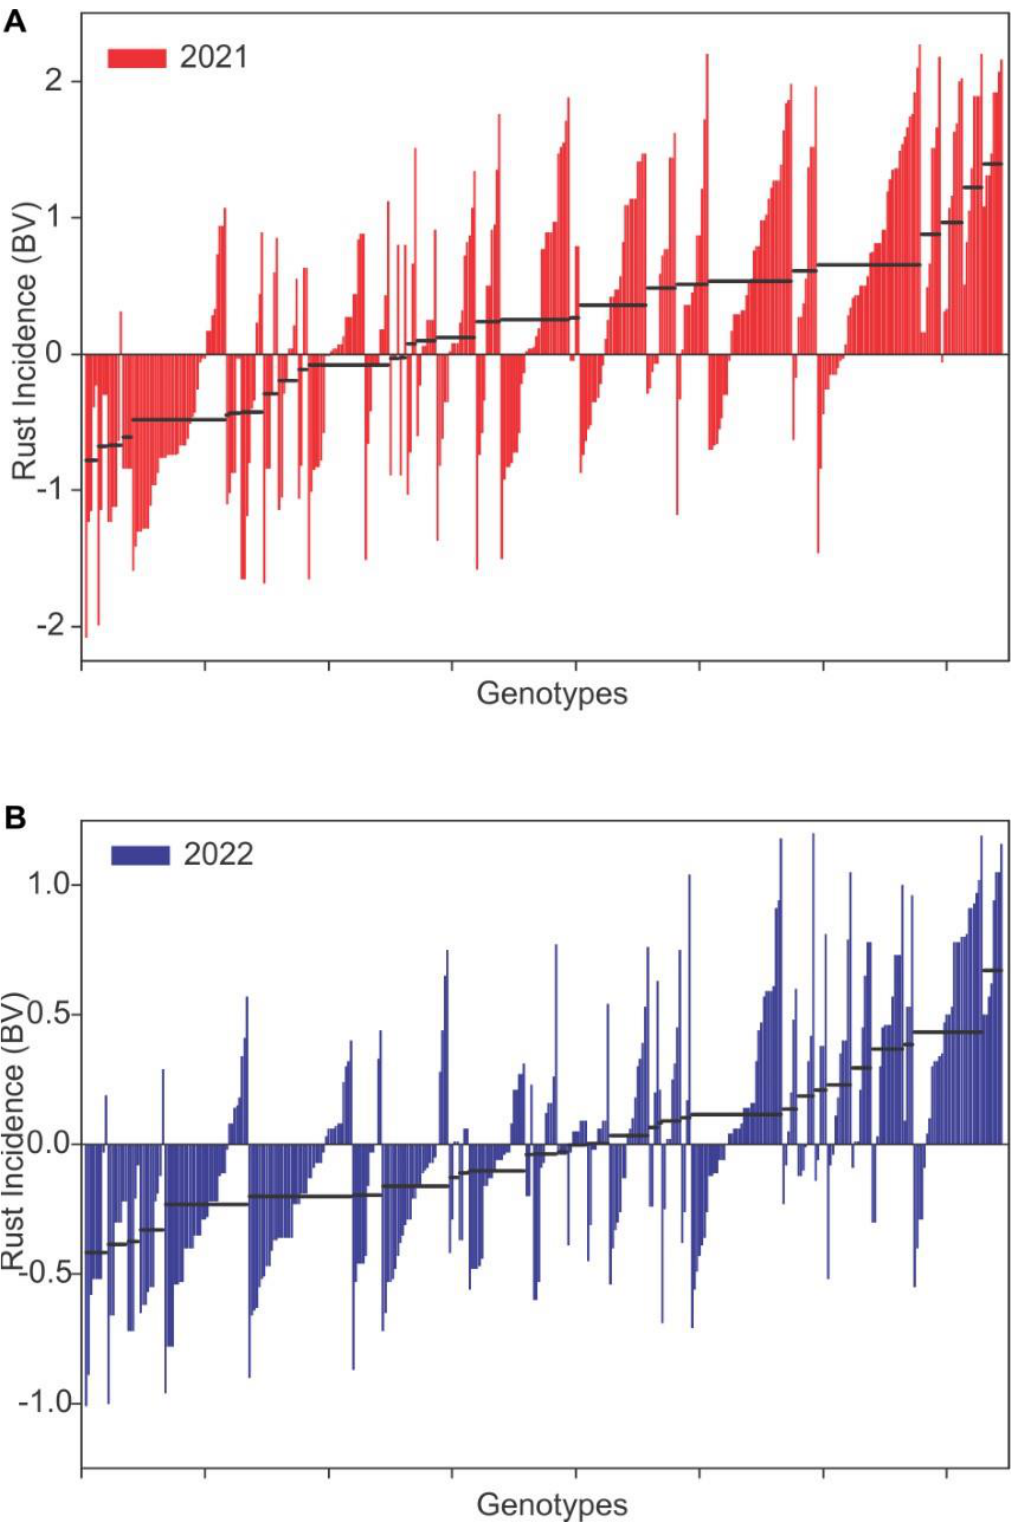
Figure 2. Distributions of breeding values for natural rust incidences predicted on generation 2 of a Summer × Kanlow switchgrass population. ( A ) Half-sib families with progeny tested in 2021. ( B ) Half-sib families with progeny tested in 2022. The black horizontal bars represent the means of the families with respective progeny as a group (width of the bars). Families and progeny were rated on a 0–4 scale in a field, near Mead,